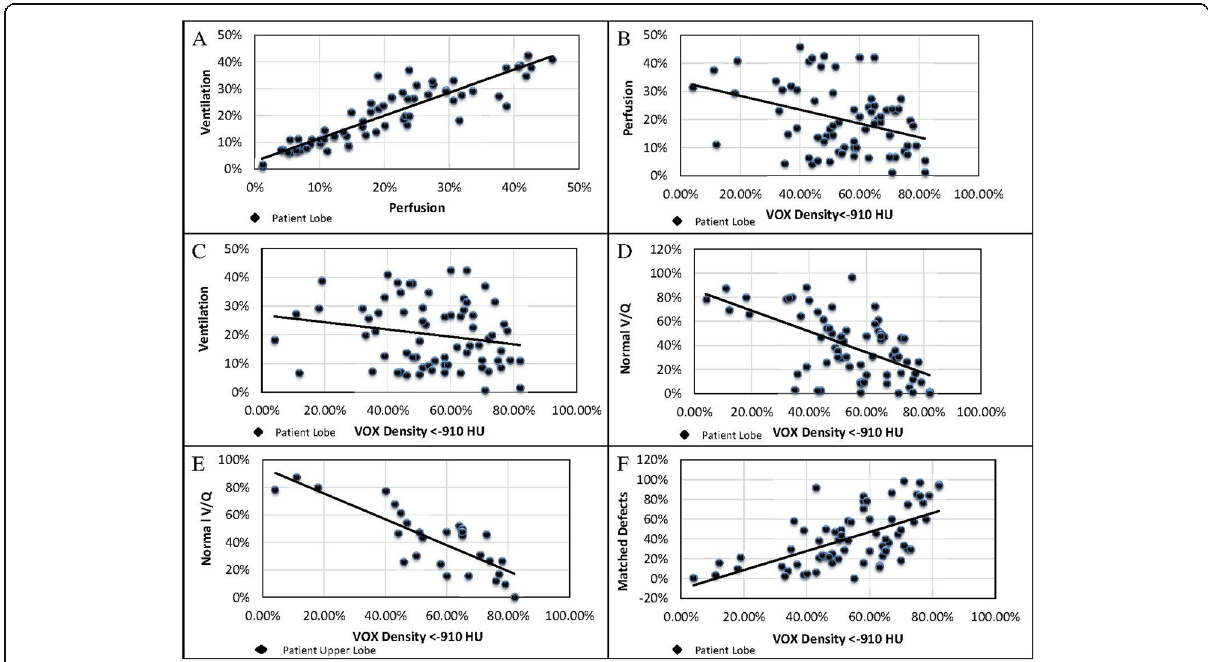
demonstrated on CT densitometry. a ) perfusion versus ventilation in all lobes. b ) voxel density versus perfusion in all lobes. c ) voxel density versus ventilation in all lobes. d ) voxel density versus proportion of lung with normal V/Q units. e ) voxel density versus proportion of upper lobes with